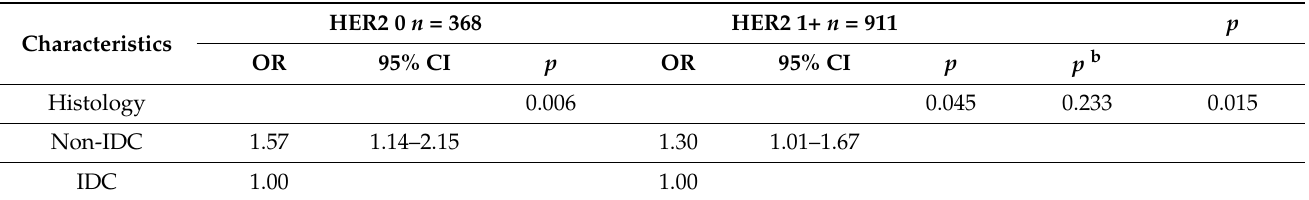
Table 2. Multivariate analysis of patient characteristics by HER2 IHC/FISH status a